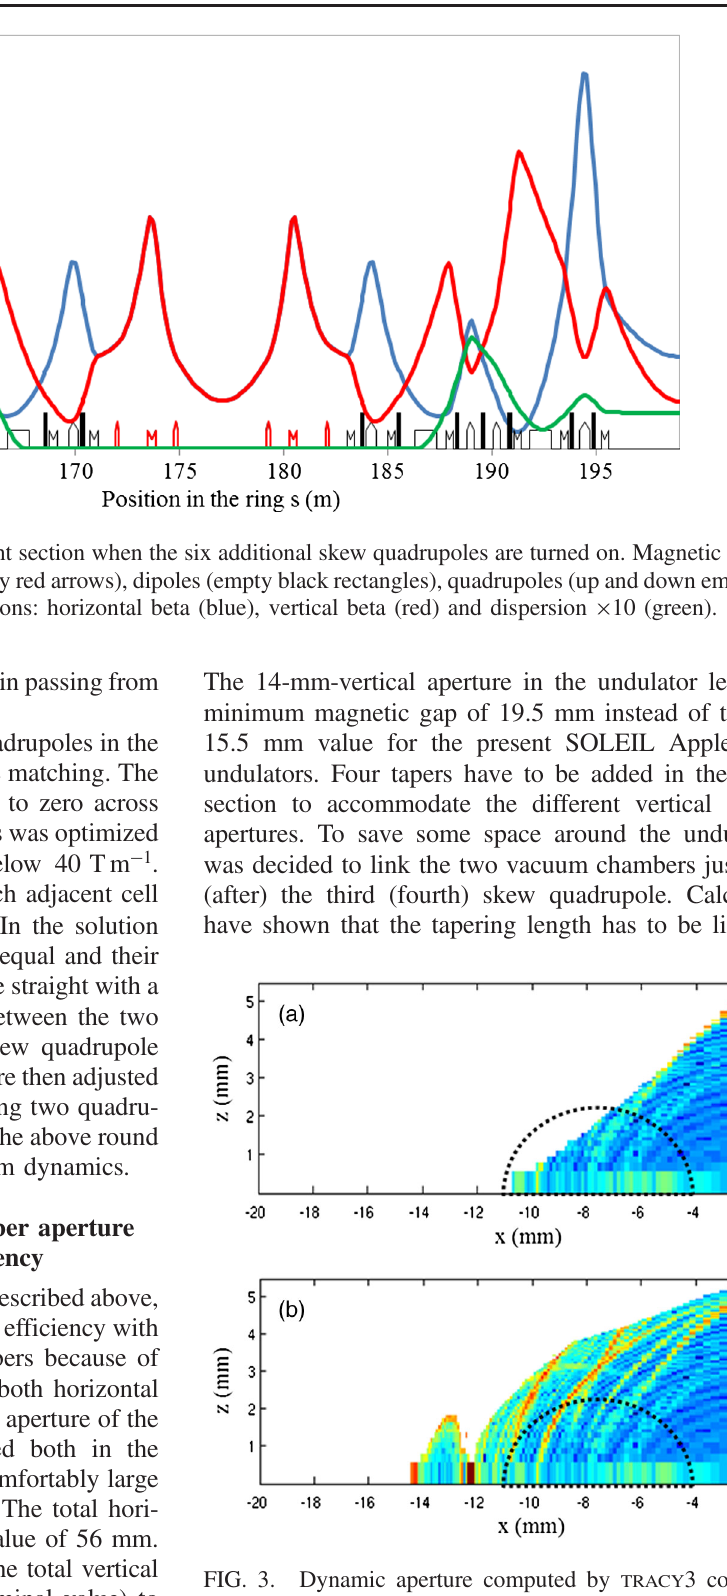
FIG. 3. Dynamic aperture computed by TRACY 3 code [8] at the middle of the injection straight section using the nominal chamber dimensions (a) and the optimized chamber dimensions (b). The area defined by a black dashed curve represents the amplitude area to be stable for the injected